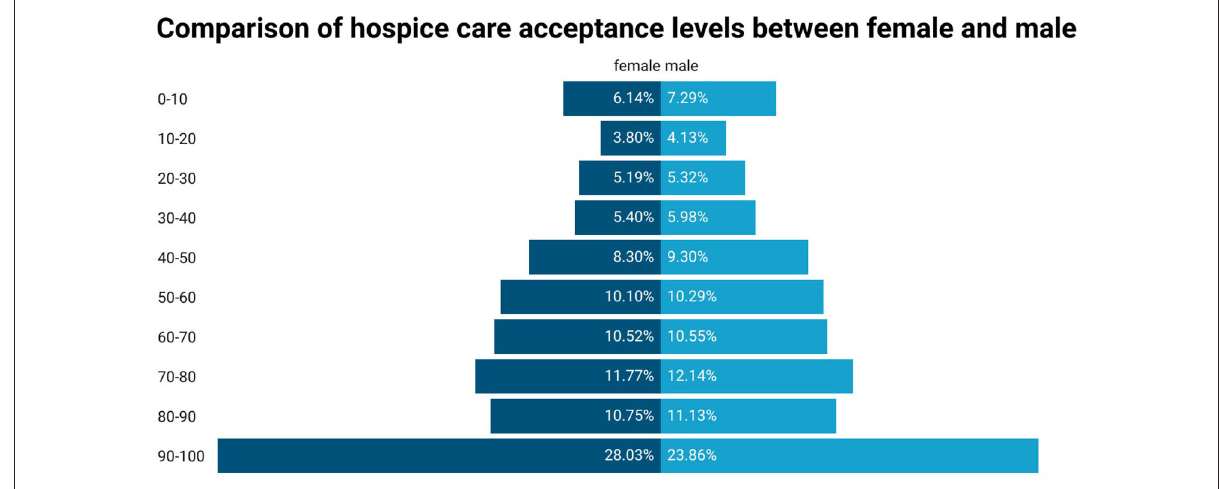
FIGURE4 Comparison of hospice care acceptance levels between female and male.